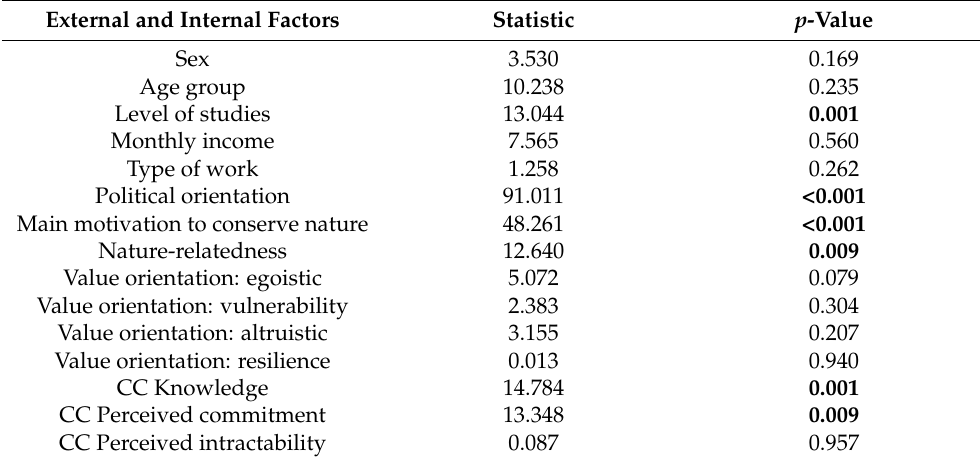
Table 1. Association between external and internal variables and religious groups.